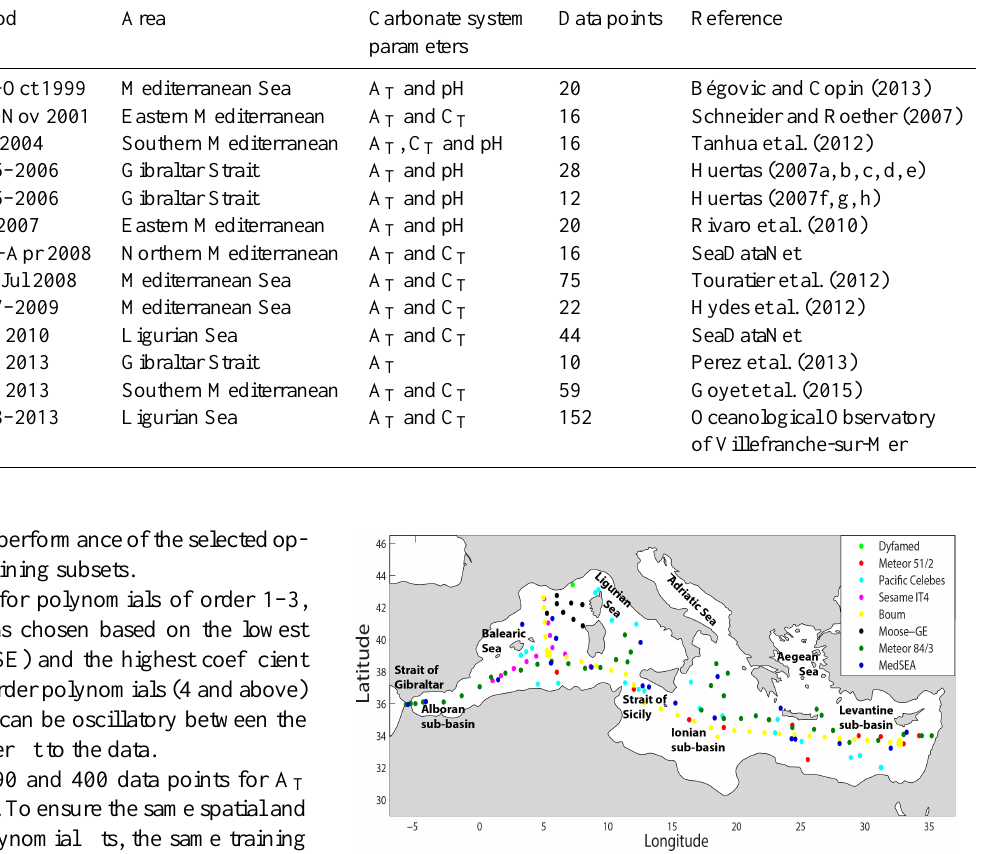
Figure 1. Spatial distribution of data points used to initiate the fits of A T and C T